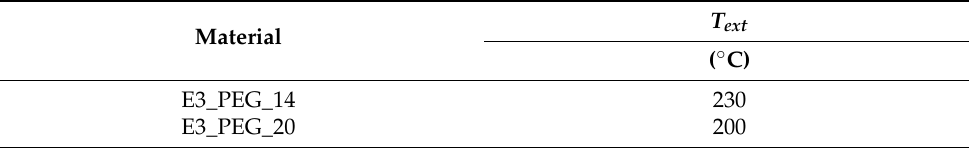
Figure 2. Illustration of the foam extruder setup; H = hopper, SM = static mixer, P = melt pump, N = nozzle. Table 2. Temperatures set on extruders for selected